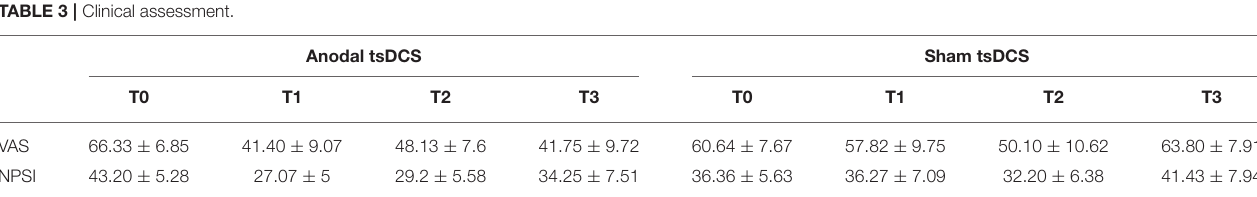
TABLE 3 | Clinical